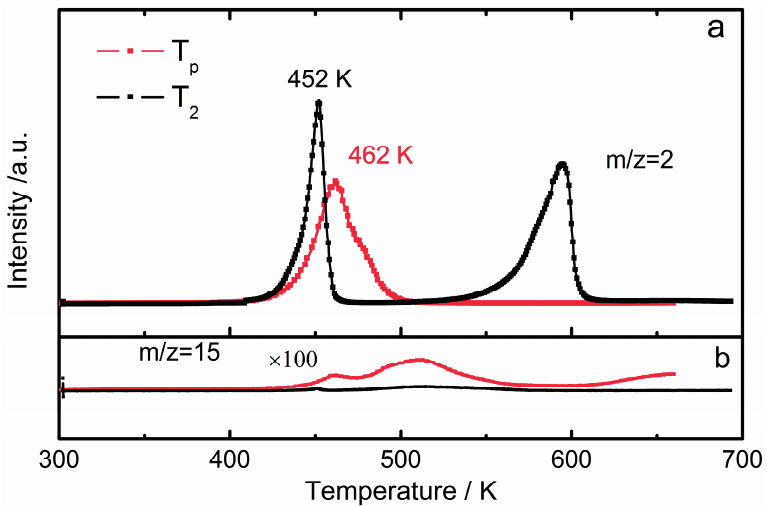
Figure 2. TPD-MS curves of 2Mg(NH 2 ) 2 –3LiH composite (T p ), and 2Mg(NH 2 ) 2 –3LiH–LiBH 4 composite (T 2 ): ( a ) H 2 signals and ( b ) NH 3